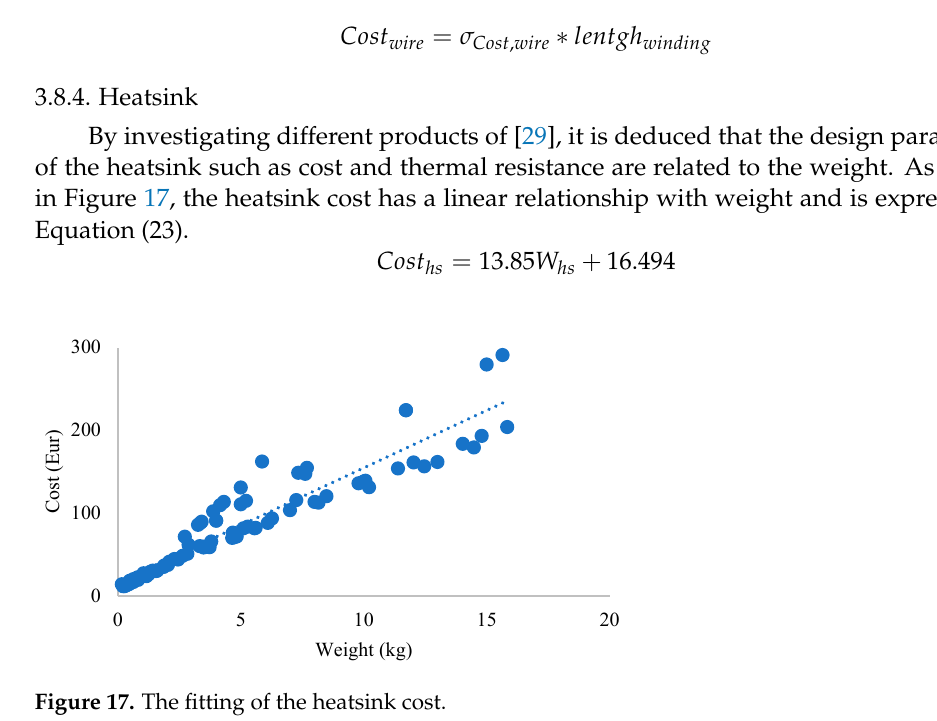
Figure 17. The fitting of the heatsink cost.